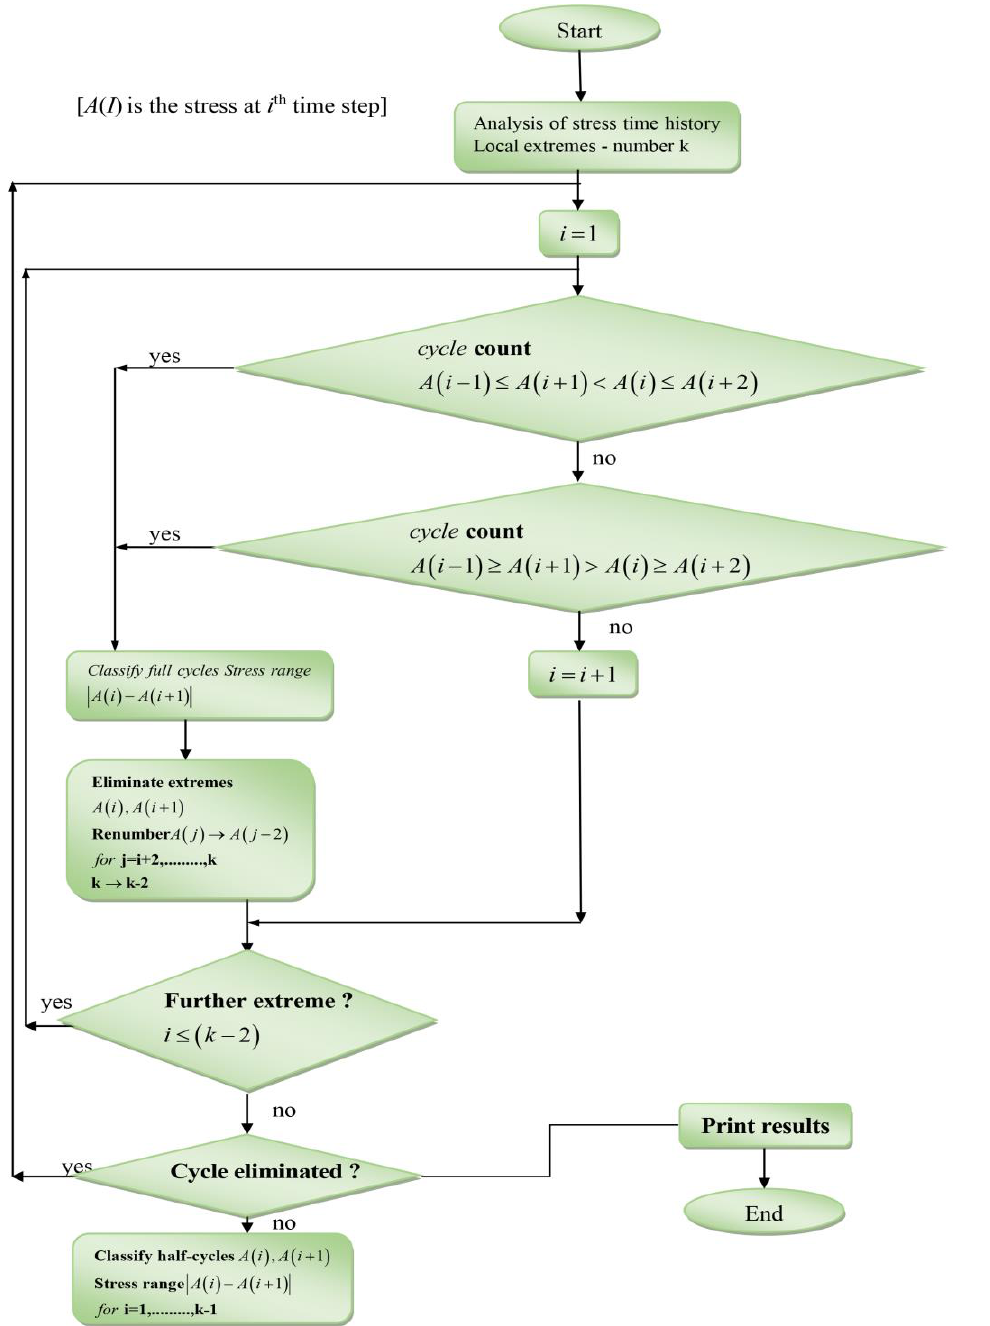
Fig .16 Fatigue life of proposed runway using dynamic